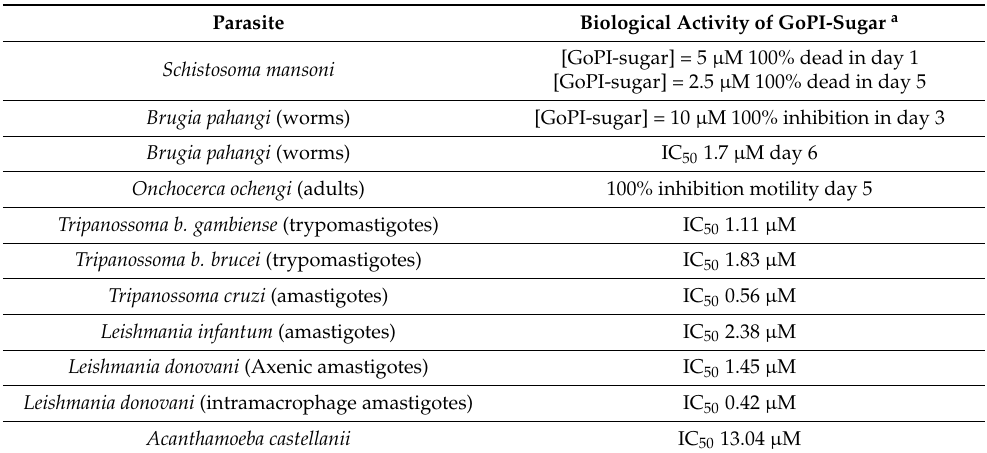
Table 2. Biological activity (worm killing activity; motility inhibition; in vitro activity) of a gold complex, GoPI-sugar, in different species [43].